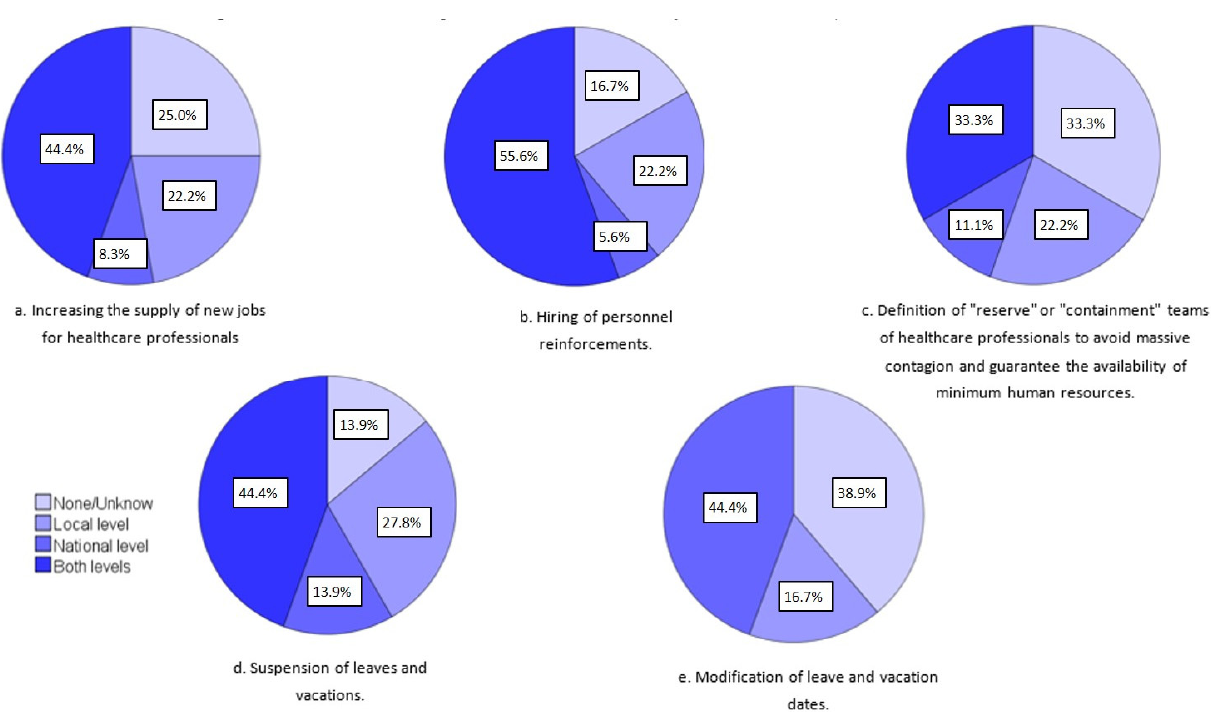
Figure 4. Initiatives to maintain or strengthen the human resources and workforce of health institu- tions from 35 countries (Argentina, Azerbaijan, Belgium, Bosnia and Herzegovina, Brazil, Bulgaria, Chile, Colombia, Croatia, Czech Republic, Denmark, Ecuador, Estonia, Finland, France, Germany, Ireland, Israel, Italy, Japan, Lithuania, Malta, Mexico, Netherlands, Peru, Poland, Portugal, Romania, Serbia, Slovakia, Spain, Sweden, Switzerland, Turkey, and the United States).